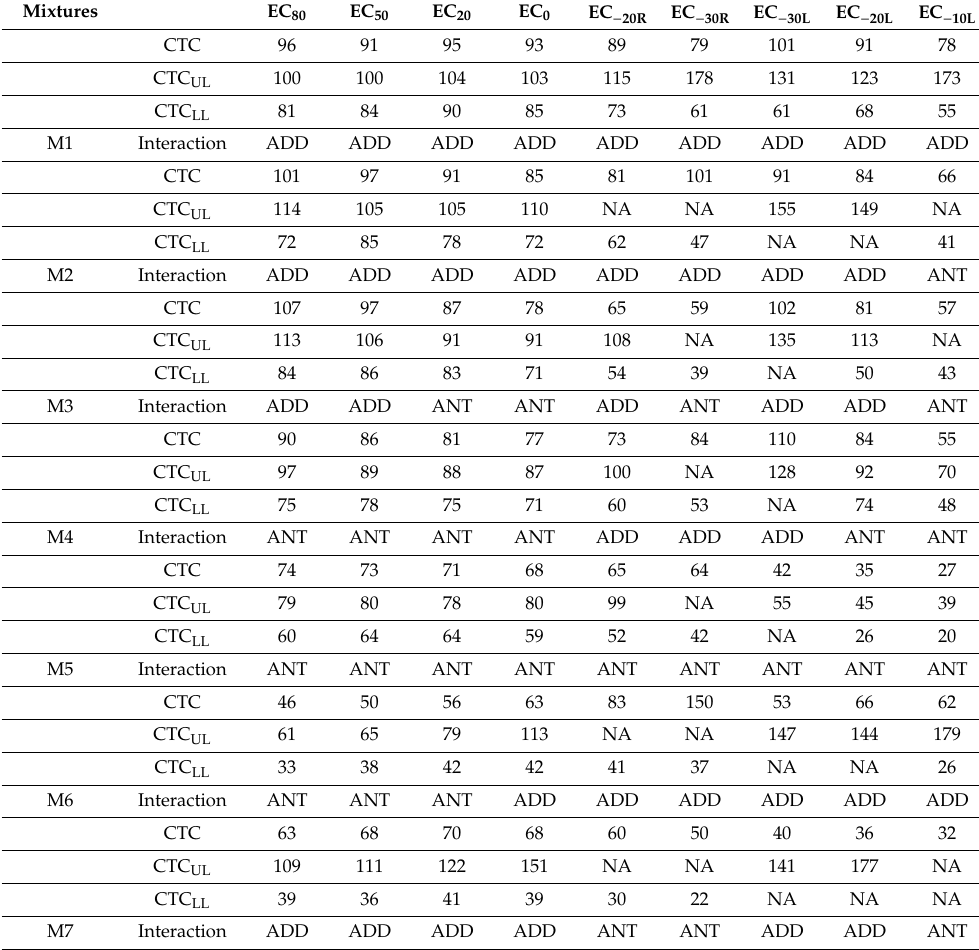
Joint toxicity e ff ect of chlortetracycline hydrochloride (CTCC) and oxytetracycline hydrochloride (OTCC) to Allivibrio fischeri